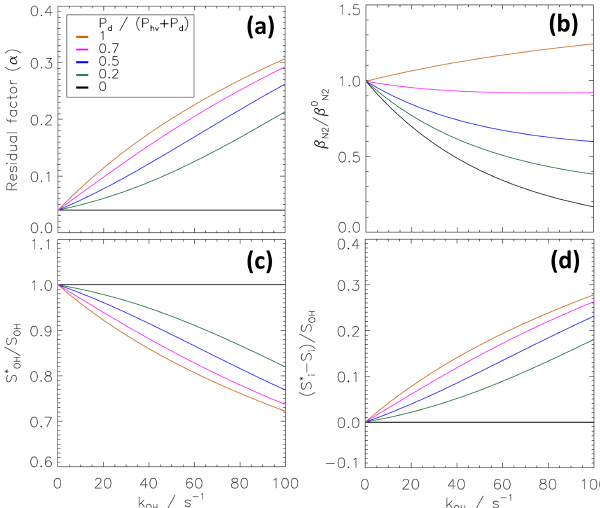
Figure 7. Theoretical k OH dependence of the residual factor α (a) /β 0 (b) . The applied model and normalized transmission β N N 2 2 (Sect. 4.2) assumes homogeneous mixing. Parameters are taken from the characterization experiments of the CMR. The dependence is shown for different ratios of dark to total atmospheric OH pro- duction rates. A ratio of one corresponds to nighttime (without pho- tolytic OH production), while a ratio of zero denotes a case without dark OH production. Panels (c, d) show the bias in the determina- tion of the ambient OH signal ( S OH ) and interference signal ( S i ), if the k OH dependence of α is not taken into account. S ∗ and S ∗ are i OH calculated with α 0 instead of α ( k OH